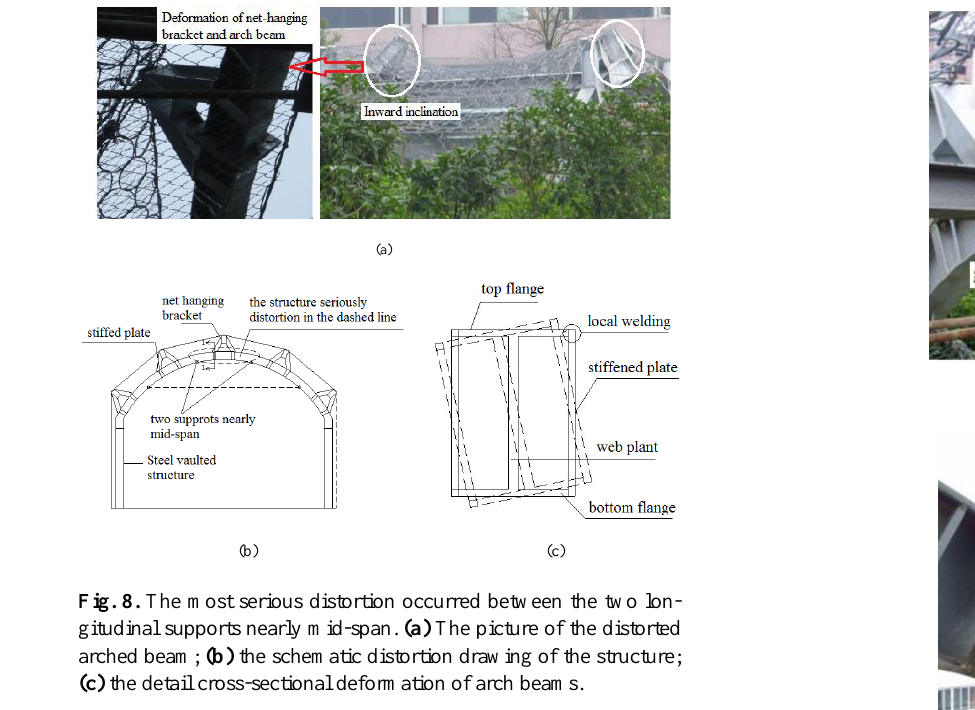
ier to be broken off. As can be seen in Figs. 6d, e and 9a,